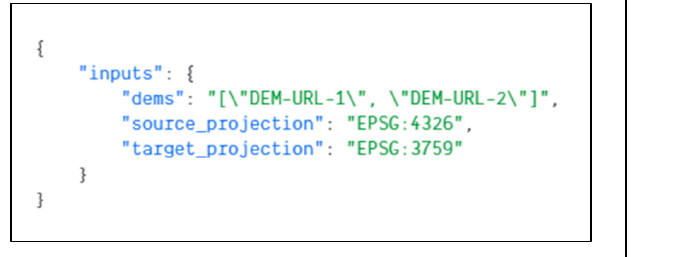
Figure 14. Visual representation of the sample workflow.